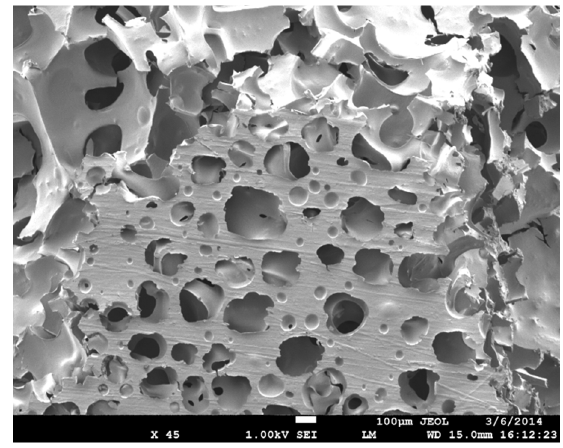
Figure 9. Scanning electron micrograph of the bottom view of PUBIMO-11.3-20 at 45× (the scale bar corresponds to 100